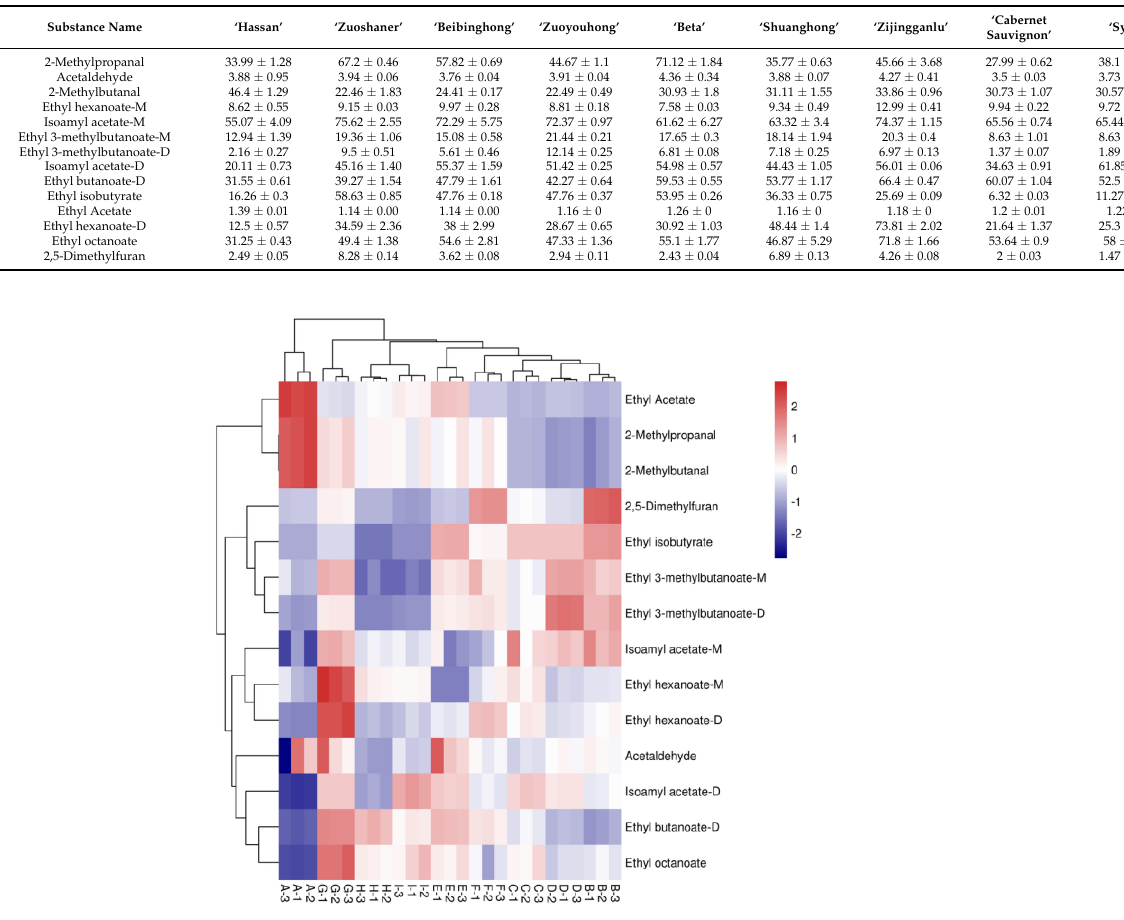
Figure 8. Heat map analysis of aromatic compounds with OAV > 1 in nine varietal wine samples. Note: From A to I are ‘Hassan’, ‘Zuoshaner’, ‘Beibinghong’, ‘Zuoyouhong’, ‘Beta’, ‘Shuanghong’, ‘Zijingganlu’, ‘Cabernet Sauvignon’, ‘Syrah’.